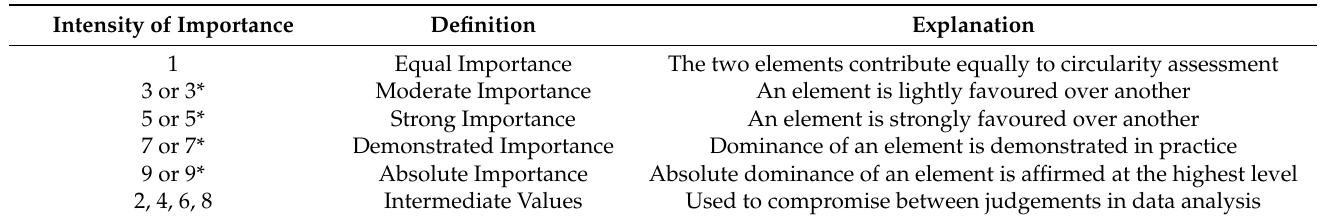
Table 3. The modified scale (9 ← 1 → 9*) used for pairwise comparisons between elements of circularity assessment (based on Saaty’s 1–9